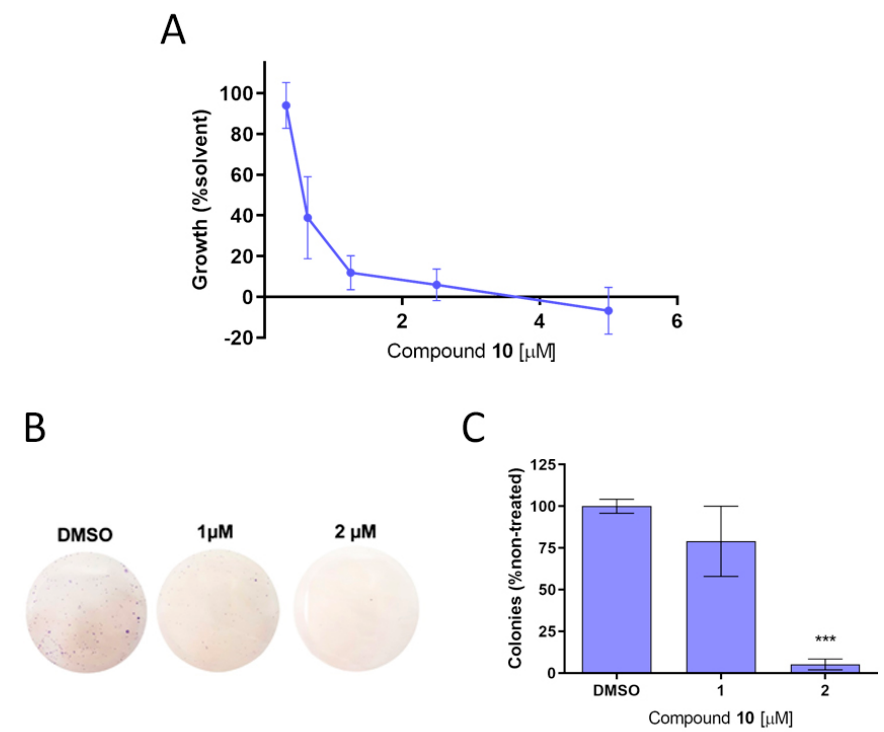
Figure 2. Norhierridin B ( 10 ) inhibits the growth of breast adenocarcinoma MDA-MB-231 cells. ( A ) Dose-response curve for the growth of MDA-MB-231 cells treated with compound 10 for 48 h, determined by SRB assay; data are mean ± SEM of four independent experiments; growth obtained with vehicle was set as 100%. (B, C ) Colony formation assay for MDA-MB-231 cells treated with compound 10 for nine days: ( B ) images correspond to a representative experiment of two; ( C ) graph represents mean ± SEM of two independent experiments; values significantly different from DMSO: *** p < 0.001, unpaired Student’s t -test.